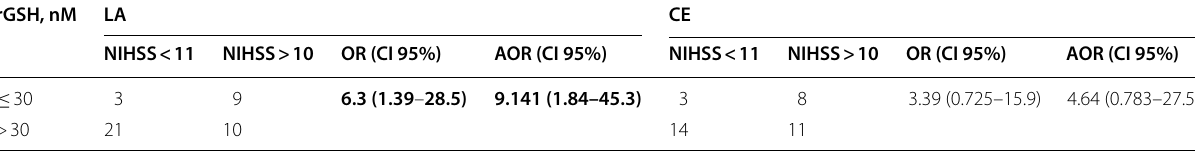
AOR adjusted odds ratio, CE cardioembolic stroke, CI 95% 95% coincidence interval, LA large-artery atherosclerosis, NIHSS National Institutes of Health Stroke Scale, OR odds ratio, rGSH reduced glutathione